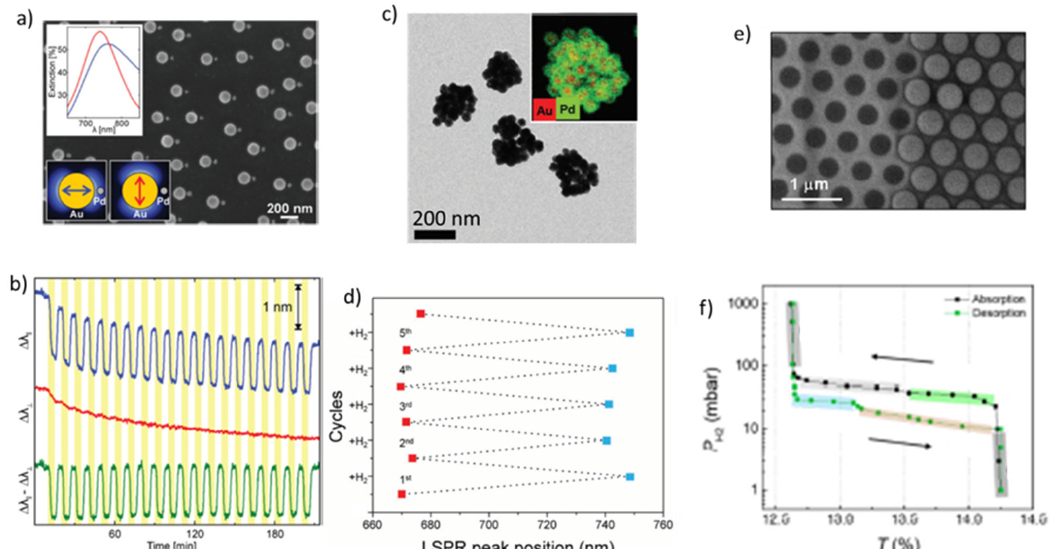
Figure 6. ( a ) SEM image and illustration of a PdAu heterodimer plasmonic H 2 sensor. The inert plasmonic Au particles have a diameter of 140 nm, while the Pd nanoparticles have a diameter of 40 nm. The top inset shows extinction spectra for the two polarizations. The red line corresponds to the perpendicular, while the blue line corresponds to the parallel polarization. The bottom inset shows a schematic illustration of the two polarizations. ( b ) PdAu heterodimer sensor response upon exposure to 4% H 2 in air. The blue and red curves correspond to LSPR peak change during the excitation in the parallel and perpendicular polarization, respectively, while the green curve represents the difference between them. White vertical areas correspond to periods when the material is exposed to pure Ar, while yellow areas to Ar containing 4% H 2 at 30 ◦ C. Reproduced from [80], with permission from The Royal Society of Chemistry, 2015. ( c ) STEM images of Au-Pd core-shell nanoparticles with an average shell thickness of 9 nm. Inset shows the EDS mapping from STEM. ( d ) LSPR changes upon 5 hydrogenation/dehydrogenation cycles of a material containing Au-Pd core–shell nanoparticles. Adapted from [83], with permission from Wiley, 2018. ( e ) SEM image of the BPNL structure. ( f ) Example of H 2 absorption–desorption isotherms of BPNL structures. Reproduced from [85], with permission from Elsevier,